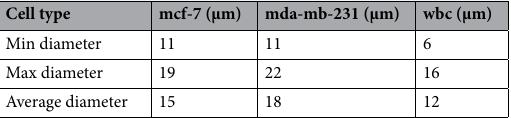
Table 1. Characteristics of cells floating in the lymphatic